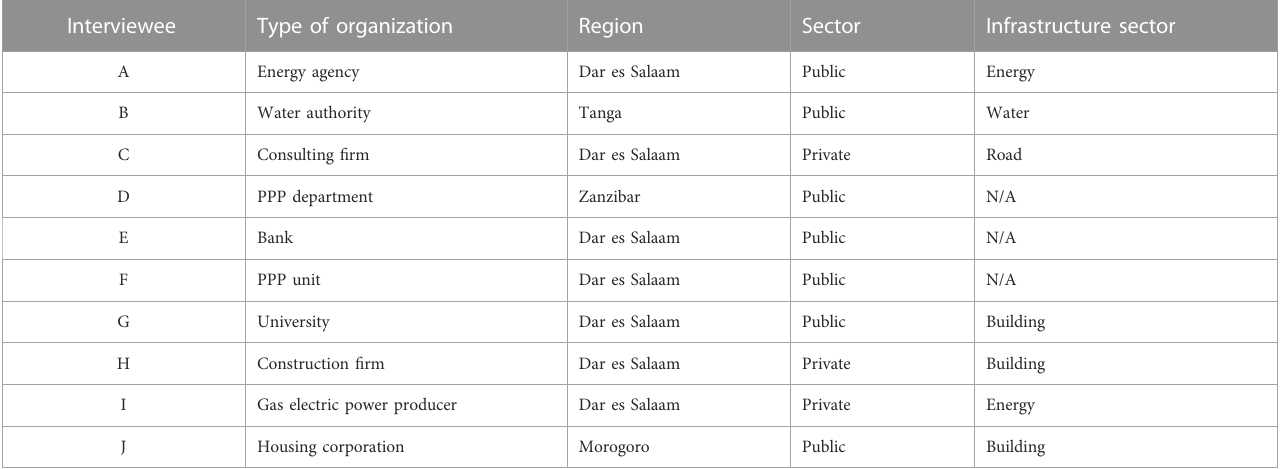
TABLE 2 Pro fi le of interviewees- organizational